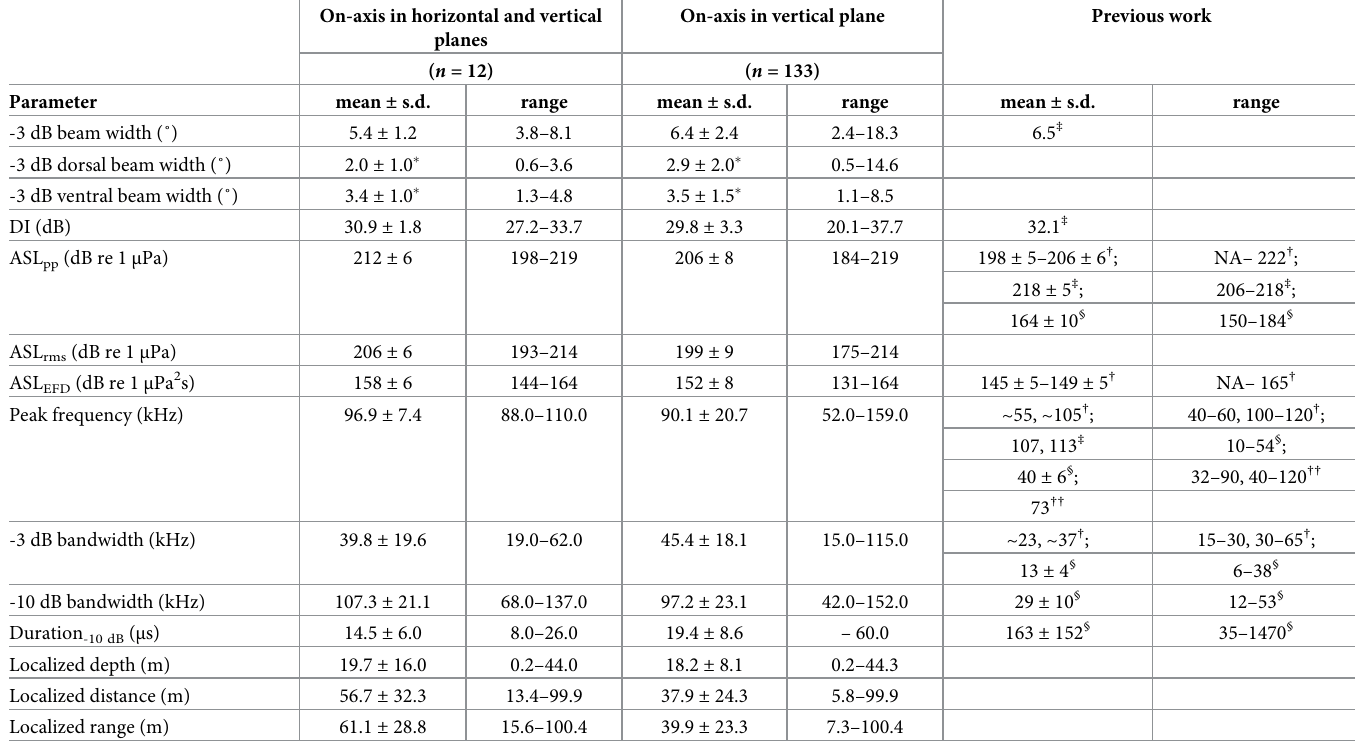
Table 1. Mean ( ± s.d.) and range of wild beluga sonar parameters calculated for all on-axis clicks with values from previous work included for comparison. On-axis in horizontal and vertical On-axis in vertical planes